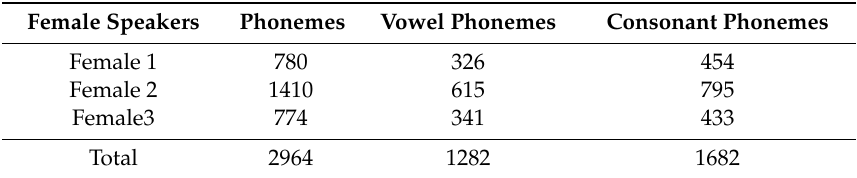
Table 3. Dataset from female speakers.